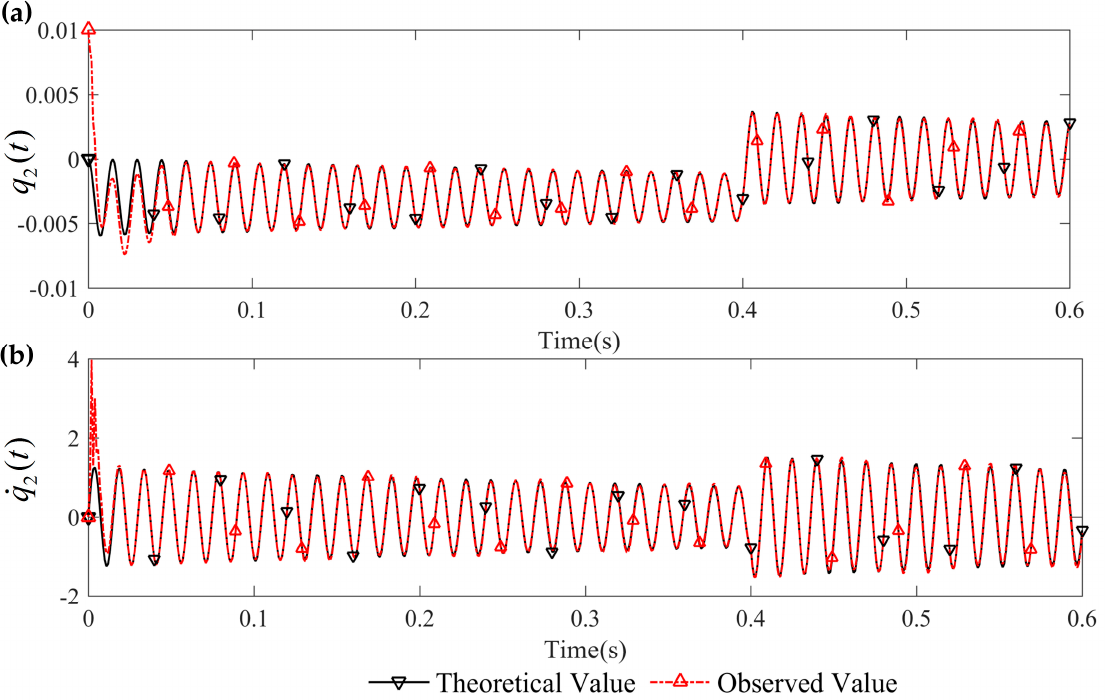
Figure 4. Tracking effect of the second-order mode and its derivative: ( a ) second-order mode tracking; ( b ) derivative of second-order mode tracking.